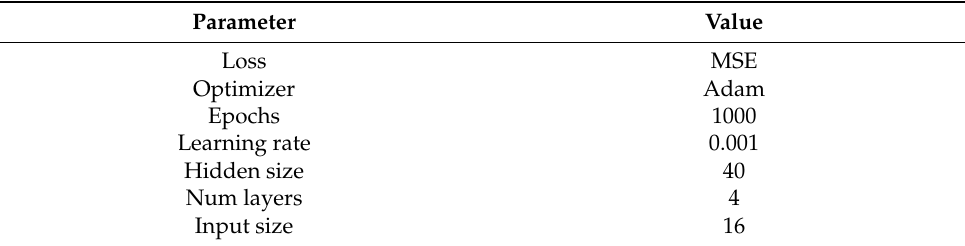
Table 2. Parameter table of the deep learning model for PM 2.5 concentration forecasting.